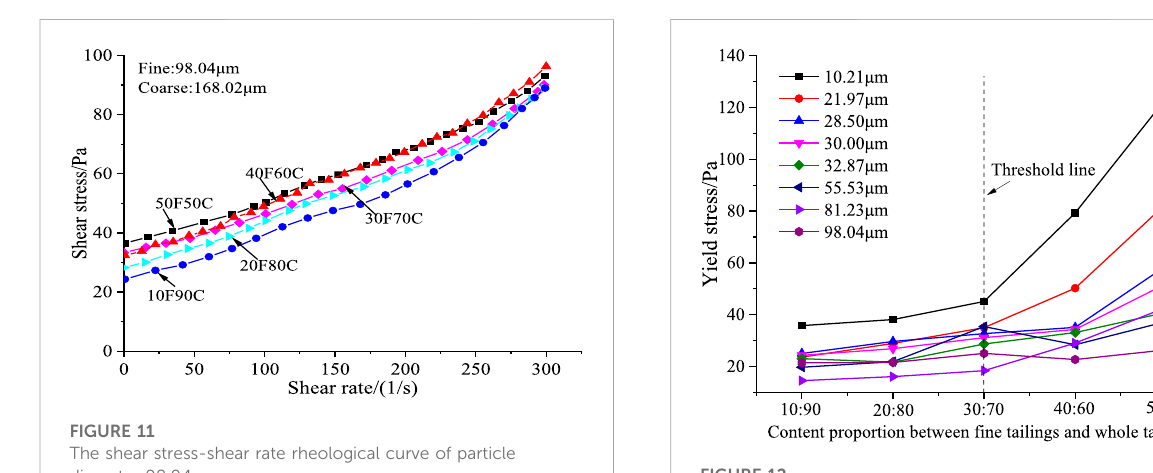
FIGURE 11 The shear stress-shear rate rheological curve of particle diameter 98.04 μ m. FIGURE 12